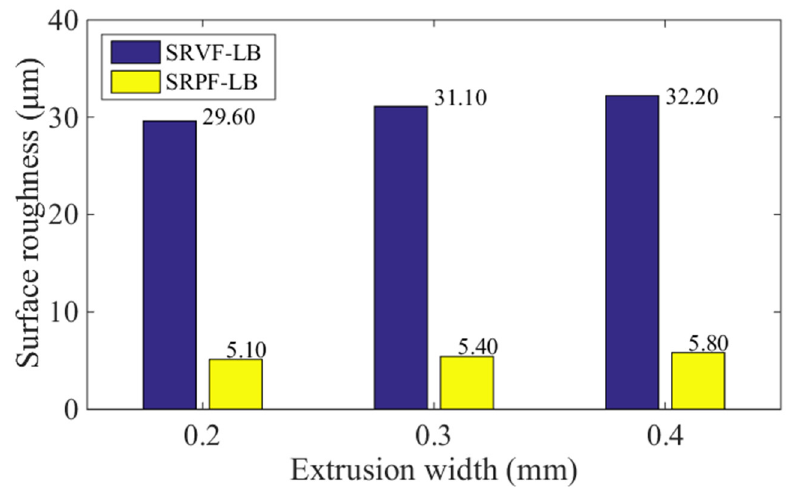
Figure 15. Effect of different extrusion width on the SRVF-LB and SRPF-LB.